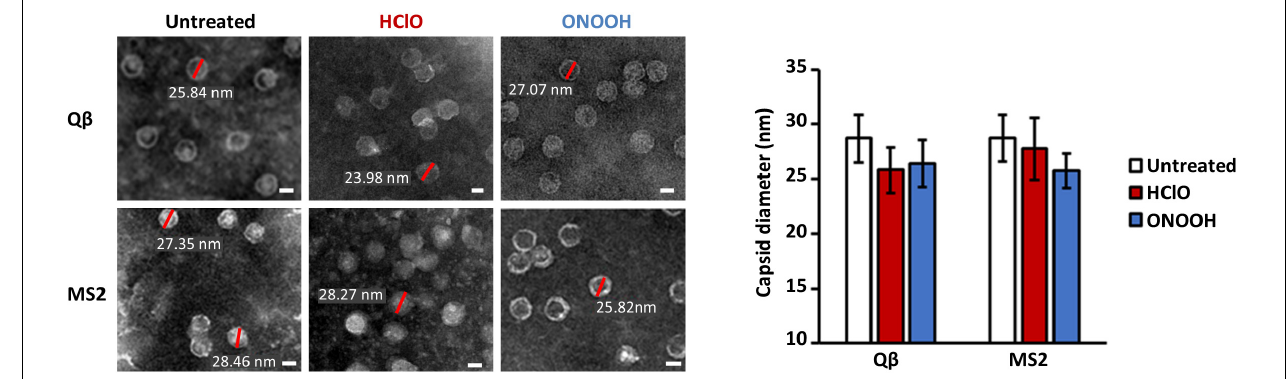
FIGURE 3 | HClO and ONOOH inactivate Q β and MS2 phages without dissolving their capsids. Left panel shows transmission electron microscopy pictures of Q β and MS2 phages with and without inactivation by HClO and ONOOH, respectively; the pictures are representative of between 1 and 3 log 10 units of inactivation. Sizes of capsids corresponding to red bars are written in white. Scale bars correspond to ∼ 20 nm and samples were observed with the magnification X 80,000. The pictures are representative of at least two independent experiments carried out on separate days. The mean capsid diameters of Q β and MS2 phages in the conditions displayed on the left panel, as observed by transmission electron microscopy, are reported on the right panel. The means capsid diameters are the results of twenty measures per condition. Error bars stand for standard